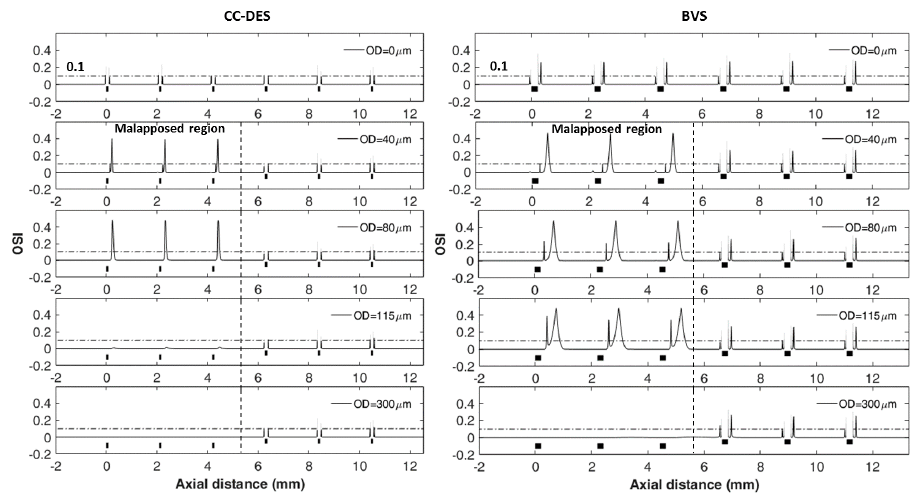
Figure 5. OSI distribution for malapposition configuration. For simplicity reasons, only five representative configurations are displayed for each strut size (MD = 0, 40, 80, 115 and 300 µm). Strut locations are indicated with black rectangles. Notice that axial distance = 0 mm corresponds to the location of the first strut. Two OSI ranges can be defined: OSI < 0.1 (Low recirculation) and OSI > 0.1 (High recirculation).